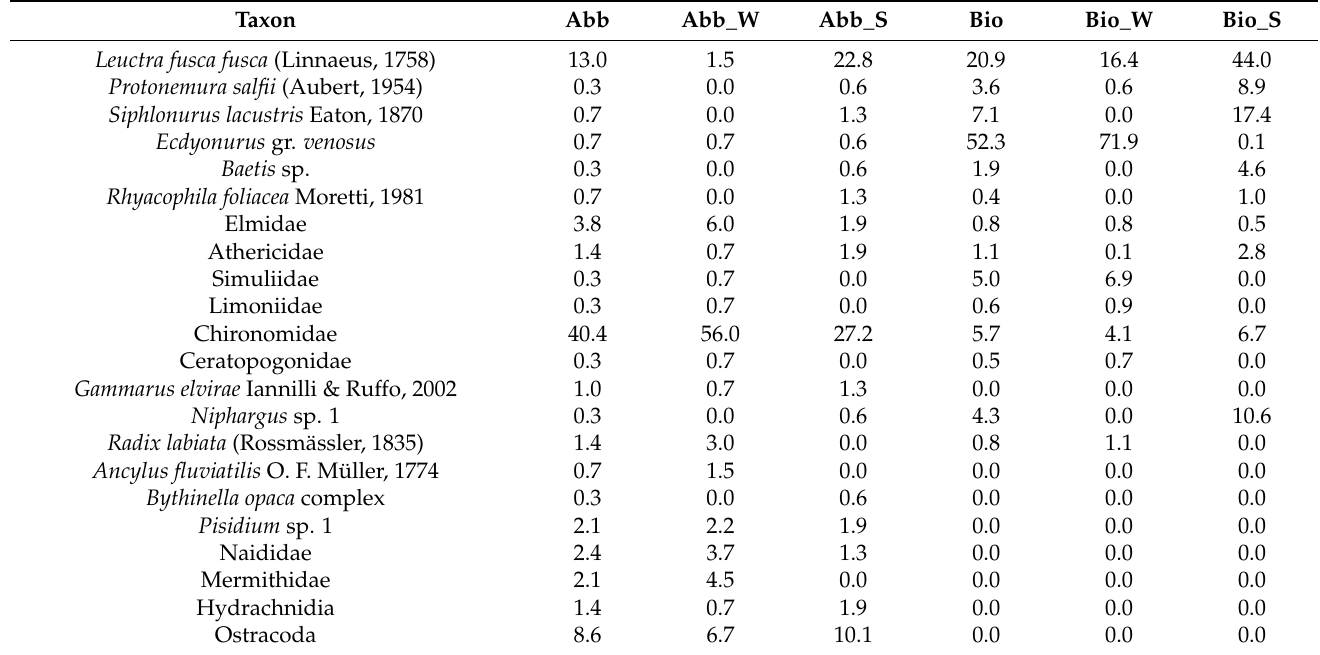
Table 1. Percentages of abundance (Abb) and biomass (Bio) of the taxa collected in the upstream stretch of the Rio Gamberale creek. Percentage data reported overall, and separately for winter (December 2014: W) and summer (June 2015: S) seasons.